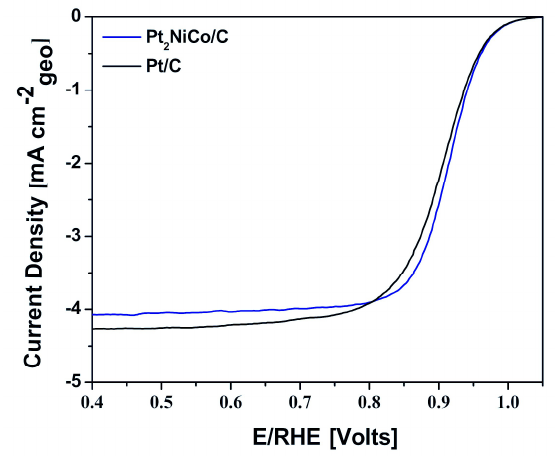
Figure 6. Potentiodynamic polarization curves of the Pt 2 NiCo / C and Pt / C catalysts measured at 1600 rpm with a scan-rate of 20 mV s − 1 .